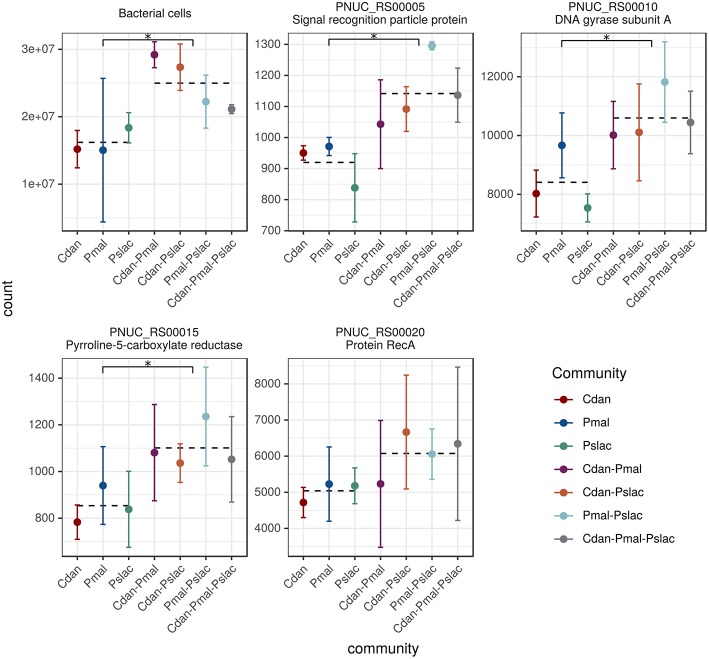
Bacterial cell counts and normalized read counts for housekeeping genes. The five subplots display the bacterial cell counts as well as normalized read counts of four housekeeping genes. The read counts act as further independent estimate of bacterial abundance changes. Since, by definition, the expression of housekeeping genes in a cell is relatively constant, changes in read counts arise from changes in the number of cells/organisms. The following housekeeping genes were considered: recombinase A, signal recognition particle protein genes, pyrroline-5-carboxylate reductase and DNA gyrase. For all counts the mean and the standard deviation over the replicates is shown colored by treatment. The means of the two tested groups (single-species vs. multi-species samples) are highlighted as dotted lines, asterisks mark significant differences in counts.